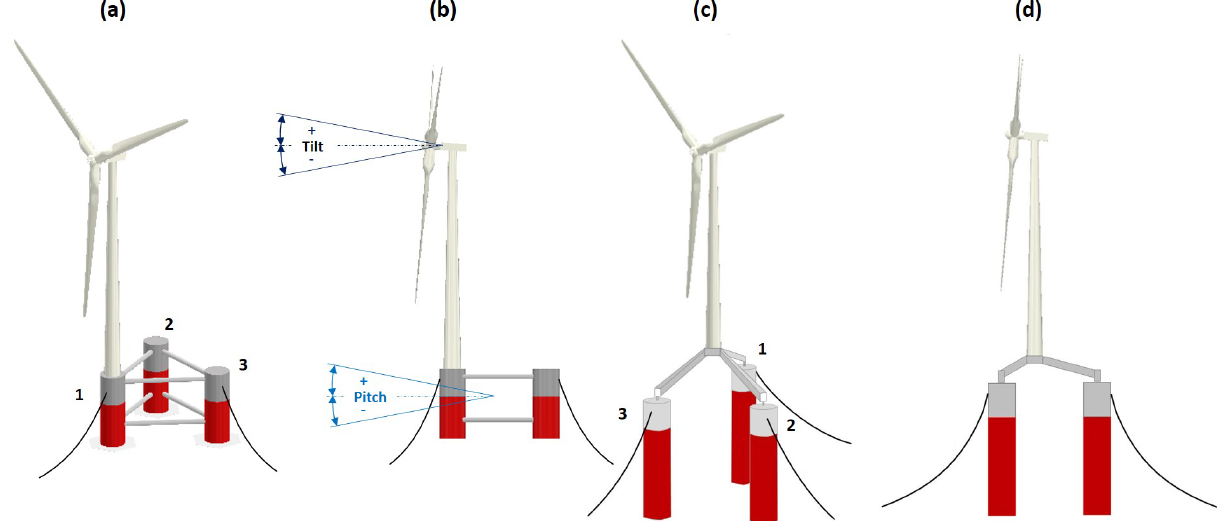
Figure 2. Sketch of Platform A, based on the WindFloat concept (Roddier et al., 1997) (a,b) . Sketch of Platform B, based on the INNWIND concept (Azcona et al., 2017; Manolas et al., 2018) (c,d) .